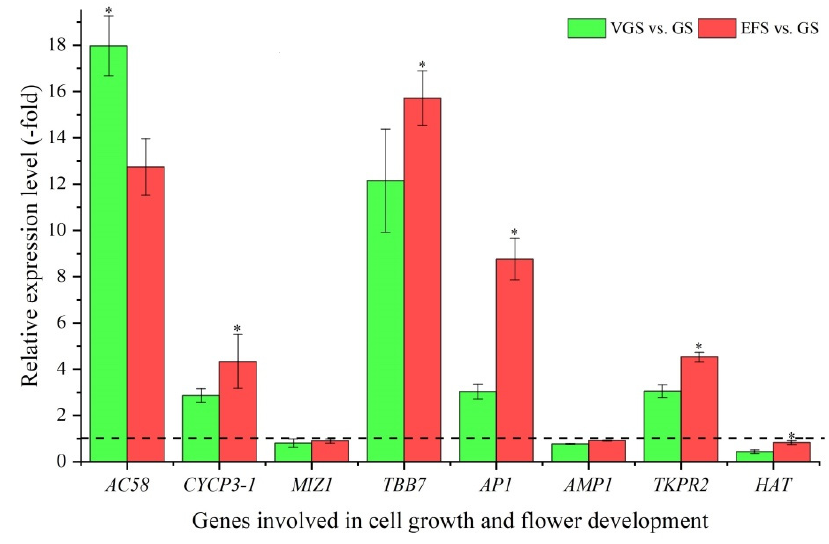
Figure 8. The relative expression level of genes involved in cell growth and flower development at VGS and EFS vs. GS, as determined by qRT-PCR (mean ± SD, n = 3). The “*” represents a significant difference ( p < 0.05) at different growth stages for the same gene.